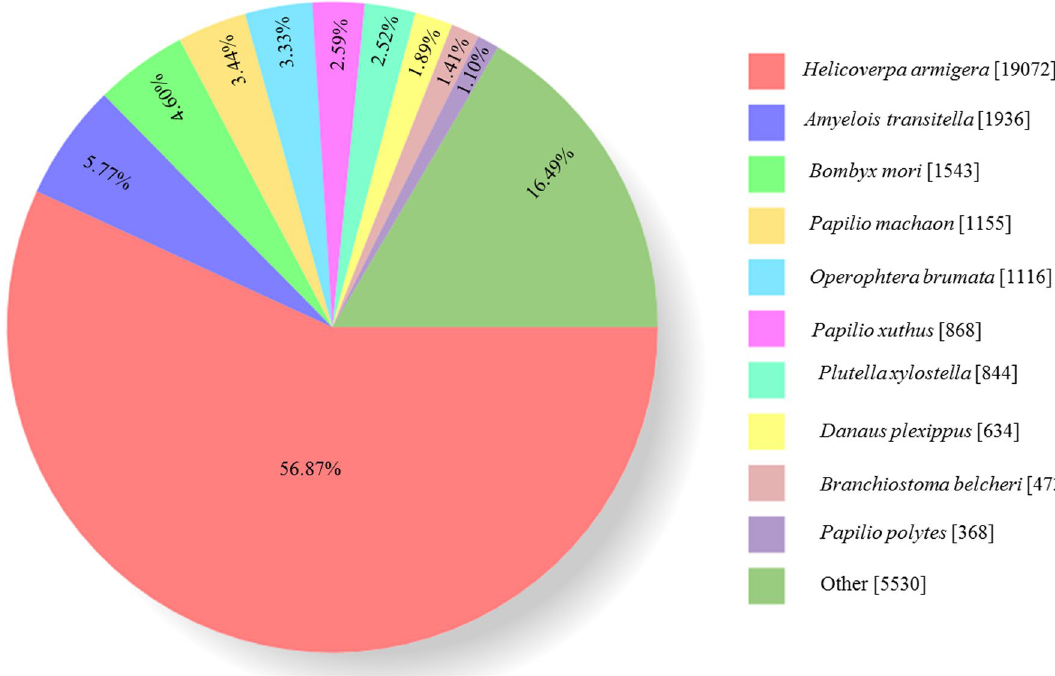
Figure 1. The Blastx results of Athetis dissimilis reproductive organs unigenes in NR